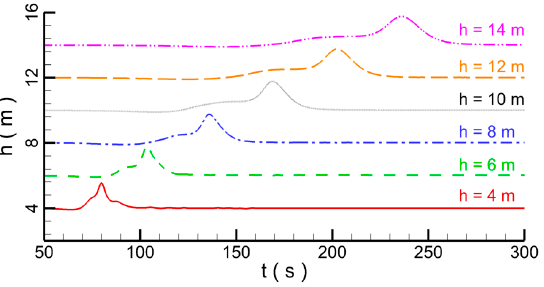
Figure 17. Time series of water elevation recorded at elevation sensor L 1 for a tsunami-like wave at different water depths.